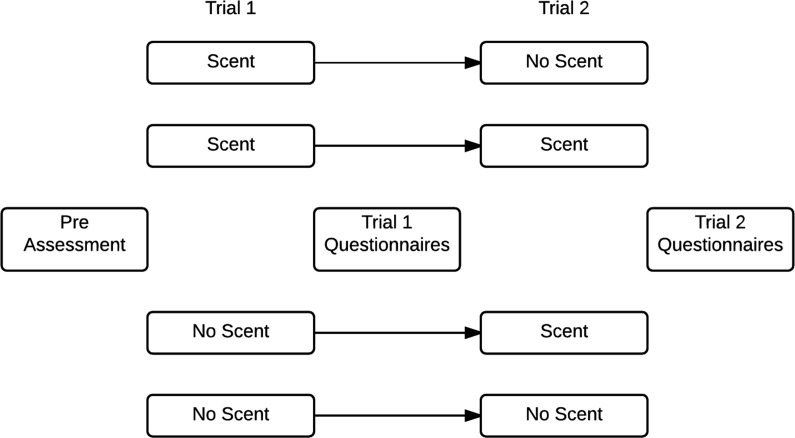
Experiment Flow.